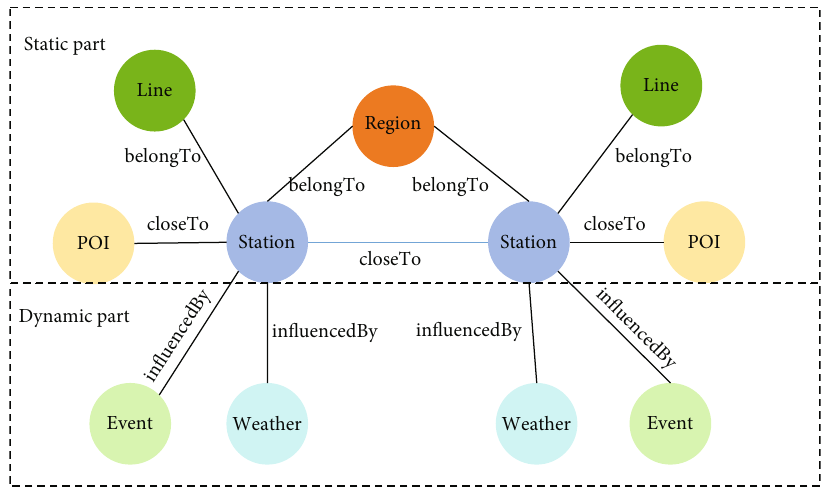
Figure 2: The main components of the metro tra ffi c knowledge graph we constructed. Table 1: Entities and attributes of metro knowledge